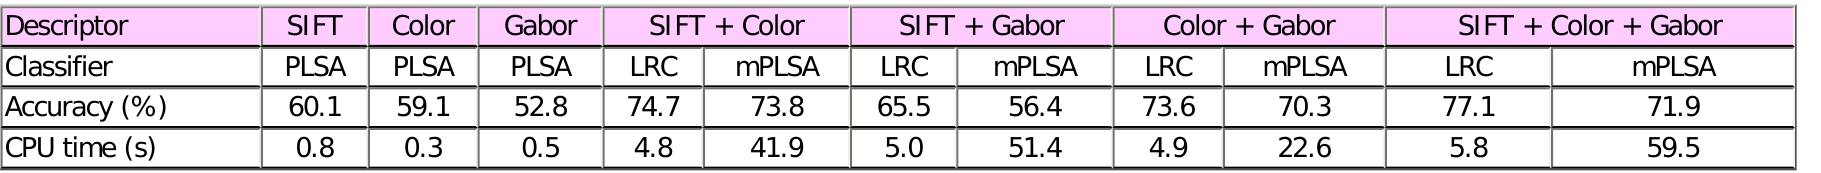
Table 6 Patch-level accuracies of linear PLSA and mPLSA classifiers and nonlinear LRC classifiers, for various posterior-probability feature sets on MSRC-9.